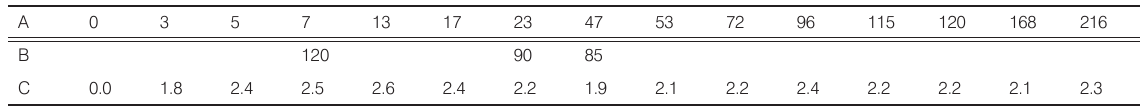
Legend to the table: A: Time laps from implantation of spacer [hours]